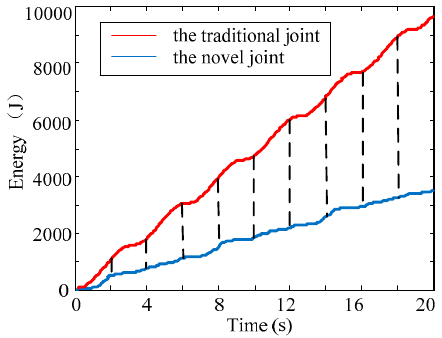
Figure 14. The energy curves of the novel joint and the traditional one.